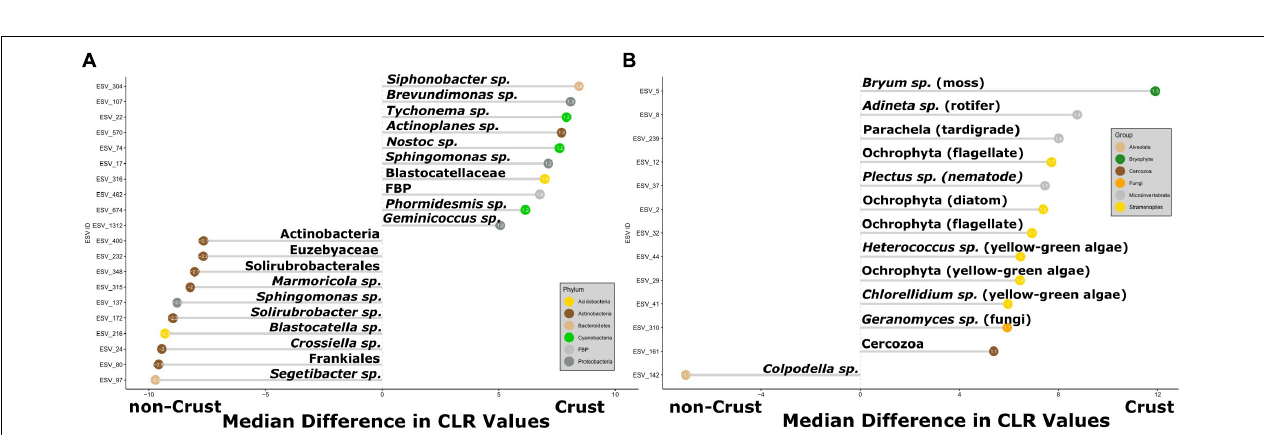
FIGURE 3 | Principal components analysis (PCA) plot of Aitchison distances with polygons capturing all samples from within a habitat. (A) 16S, (B) 18S. Pairwise PERMANOVA significance test revealed the centroid of each habitat as significantly different from all other habitats for both the bacterial and eukaryotic communities (16S p = 0.001; 18S p < 0.006).